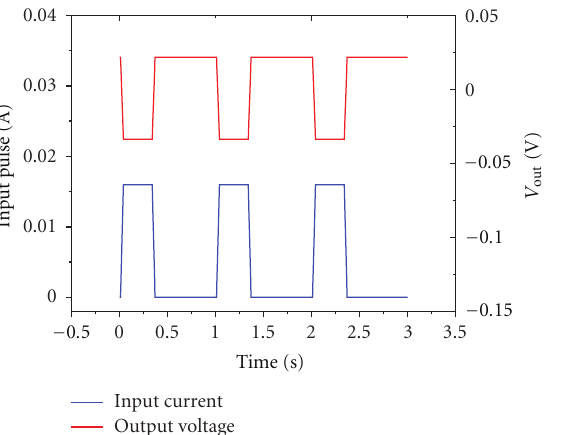
Figure 11: Reference input current (A) and output voltage (V) data for the pulse parameter as an initial value.